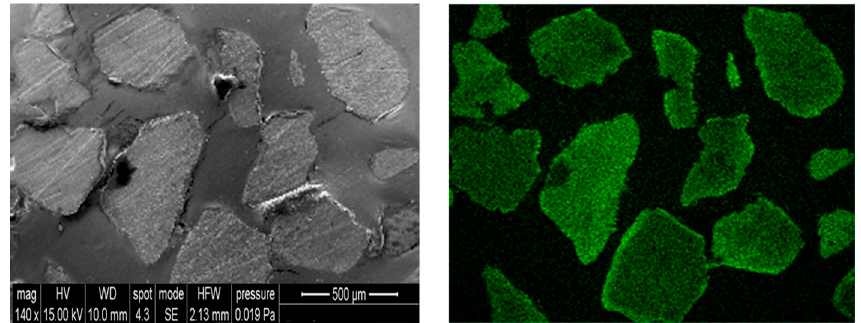
Figure 2. SEM image (left) and Mg EDX mapping (right) of 20% MgO/AC.